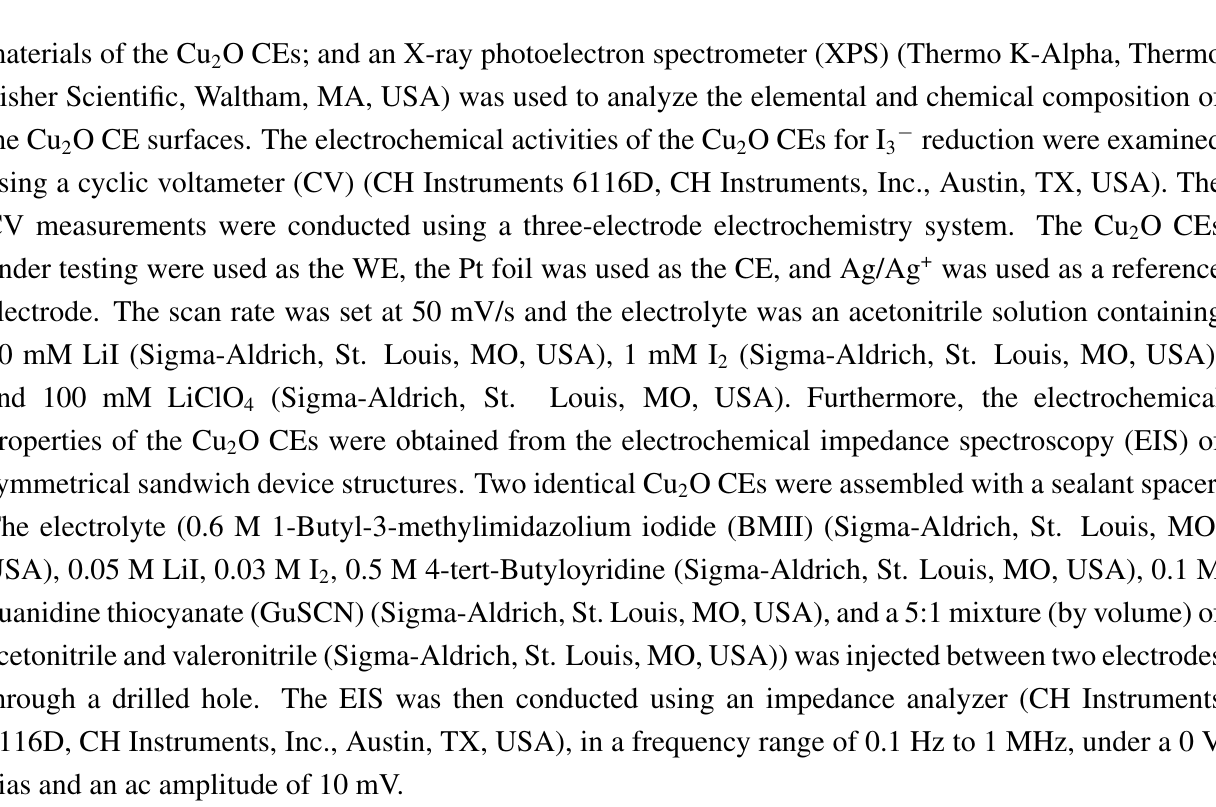
O counter electrode; and ( b ) the 2 O 2